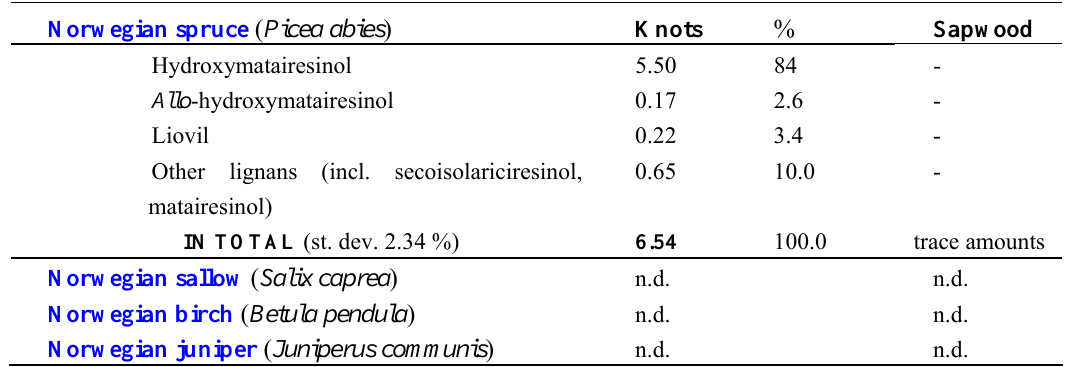
Table 3. Lignan analyses of Norwegian spruce, sallow, birch and juniper; content (%, w/w) and distribution (% of total) a